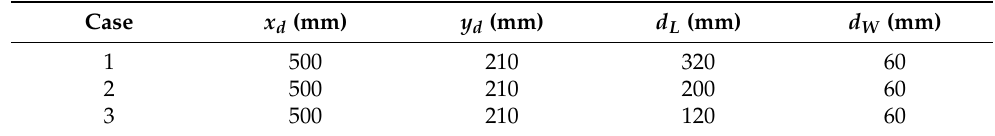
Table 3. The different skin-spar debond cases